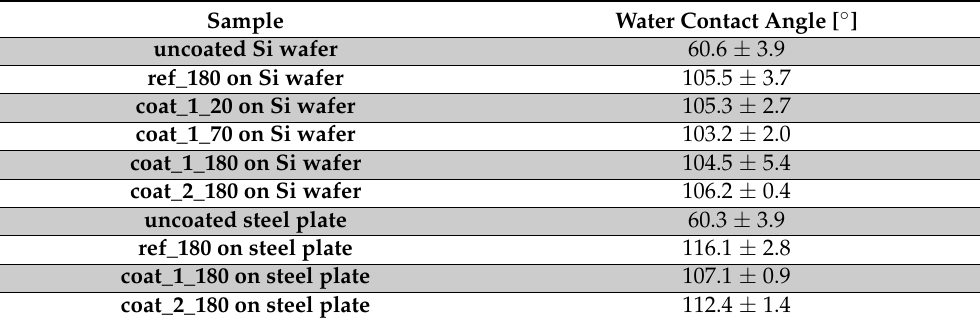
Table 5. Water contact angles of Si wafers and steel plates prior to activation and coating as well as coated with ref_180, coat_1_20, coat_1_70, coat_1_180 and